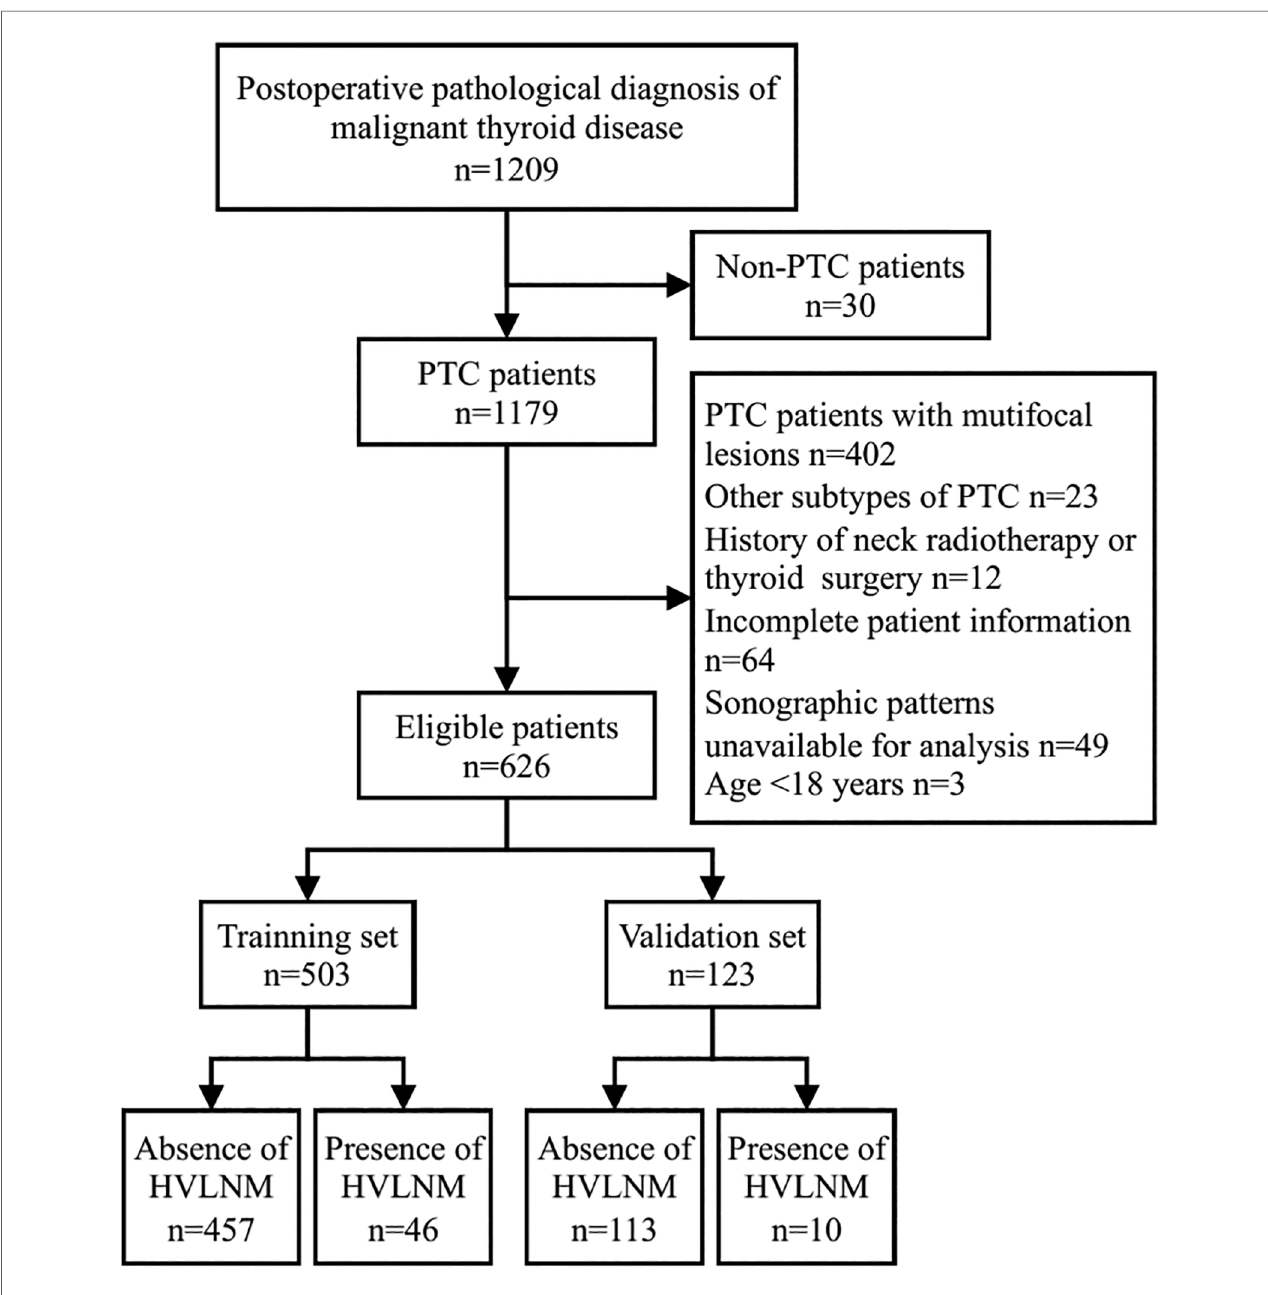
FIGURE 1 The fl owchart of the patient selection